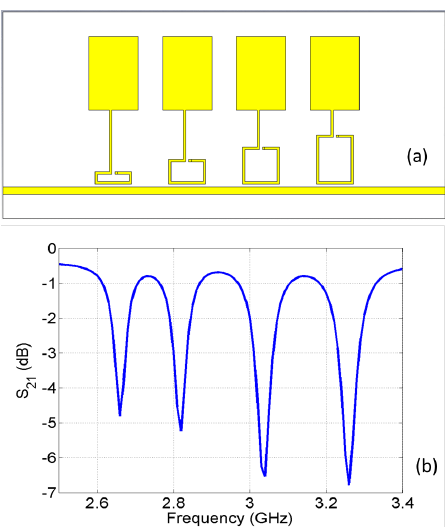
Figure 13. ( a ) A model of a capacitive sensor array coupled to a microstrip line through split rings of different dimensions; ( b ) simulated transmission spectrum of the unloaded line.